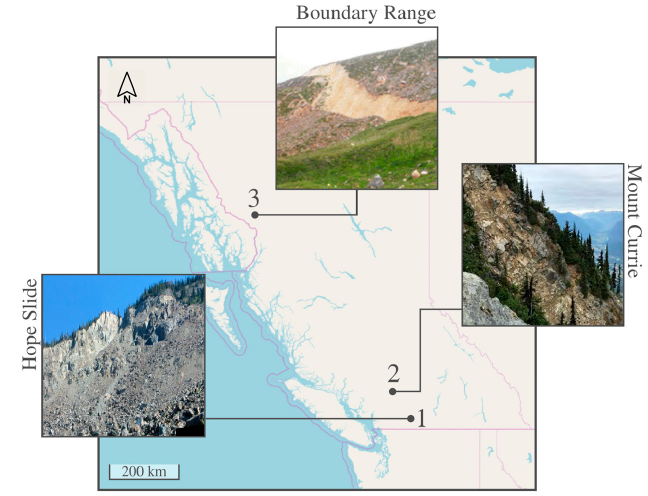
Figure 1. Case studies processed with TerraSAR-X Staring Spotlight Interferometric Synthetic Aperture Radar (InSAR) and their locations. (1) Hope Slide, (2) Mount Currie, (3) Boundary Range.